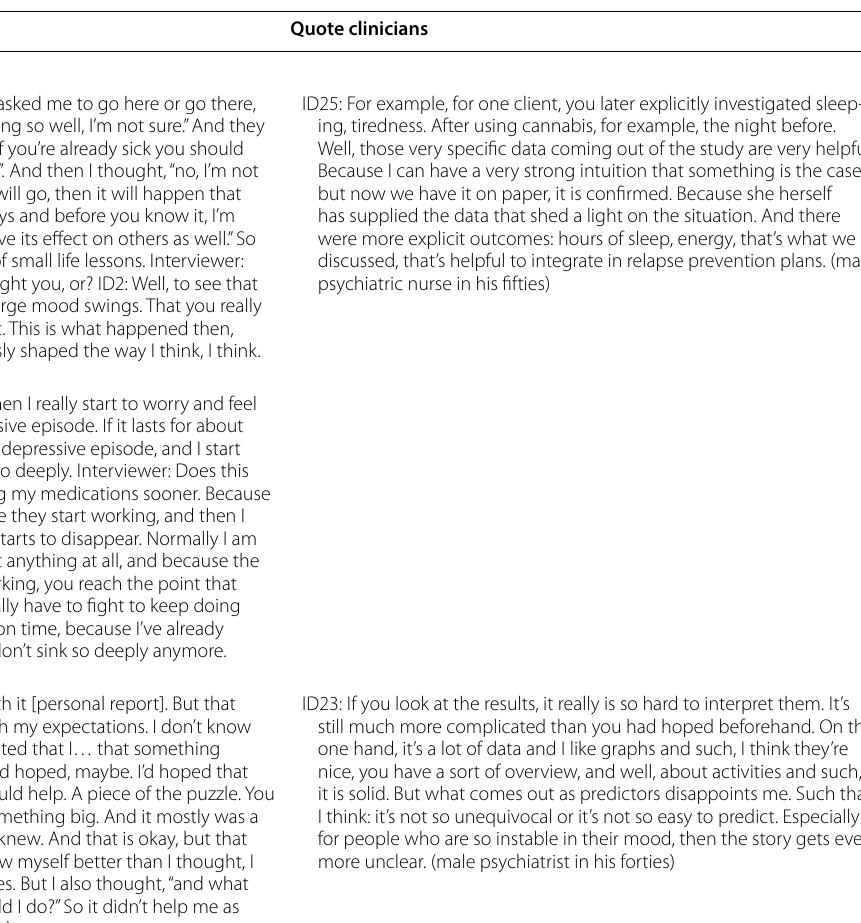
Table 3 Quotes related to theme 3 (effects of personal report and feedback session) and theme 4 (recommendations on the use of ESM in clinical practice) Quote patients Quote